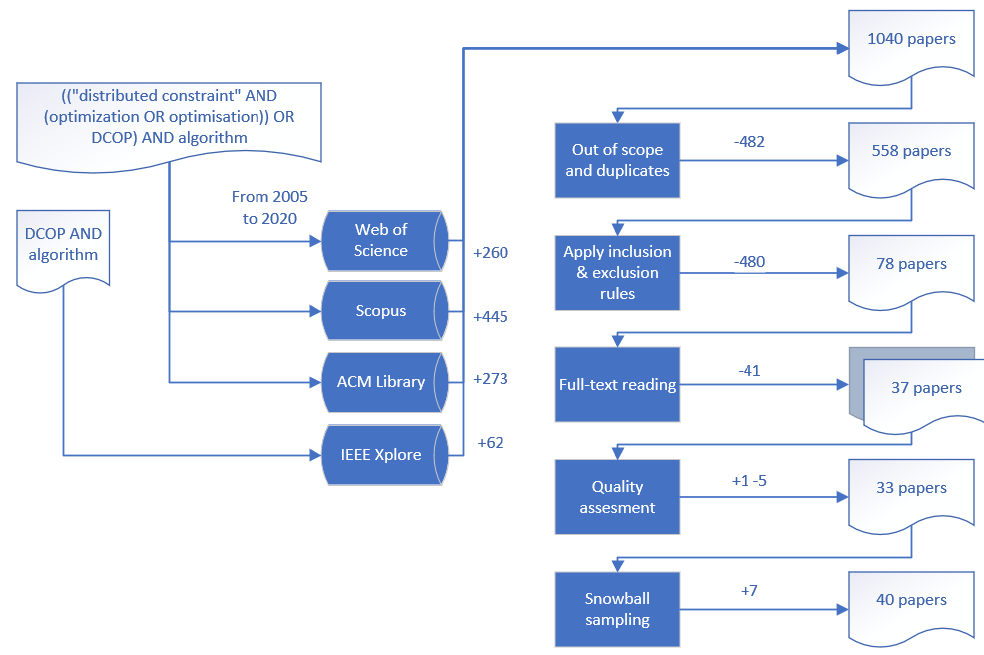
Figure 5. Search and study selection